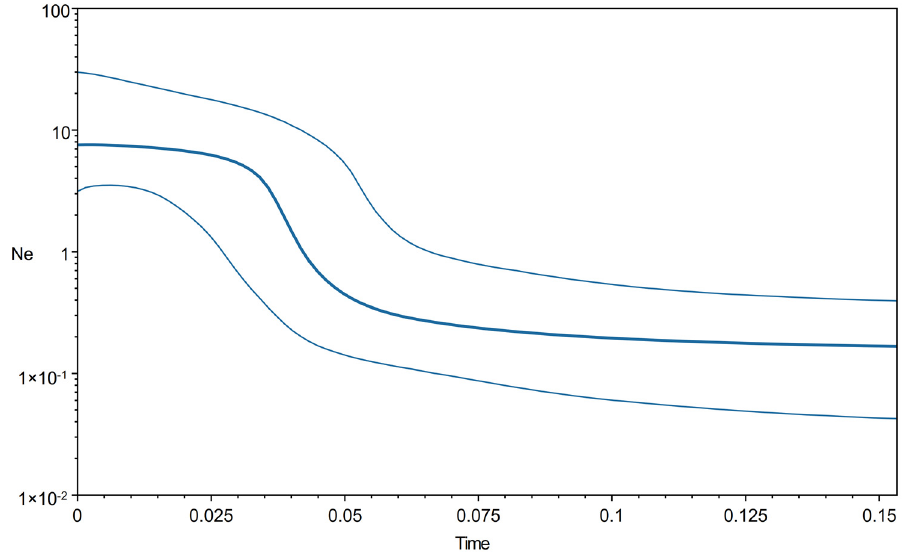
Figure 4. Bayesian skyline plot of the effective population sizes through time for Epinephelus awoara . The y -axis is the product of effective population size (Ne) and generation length in a log scale while the x -axis is the time scale before present in units of million years ago.